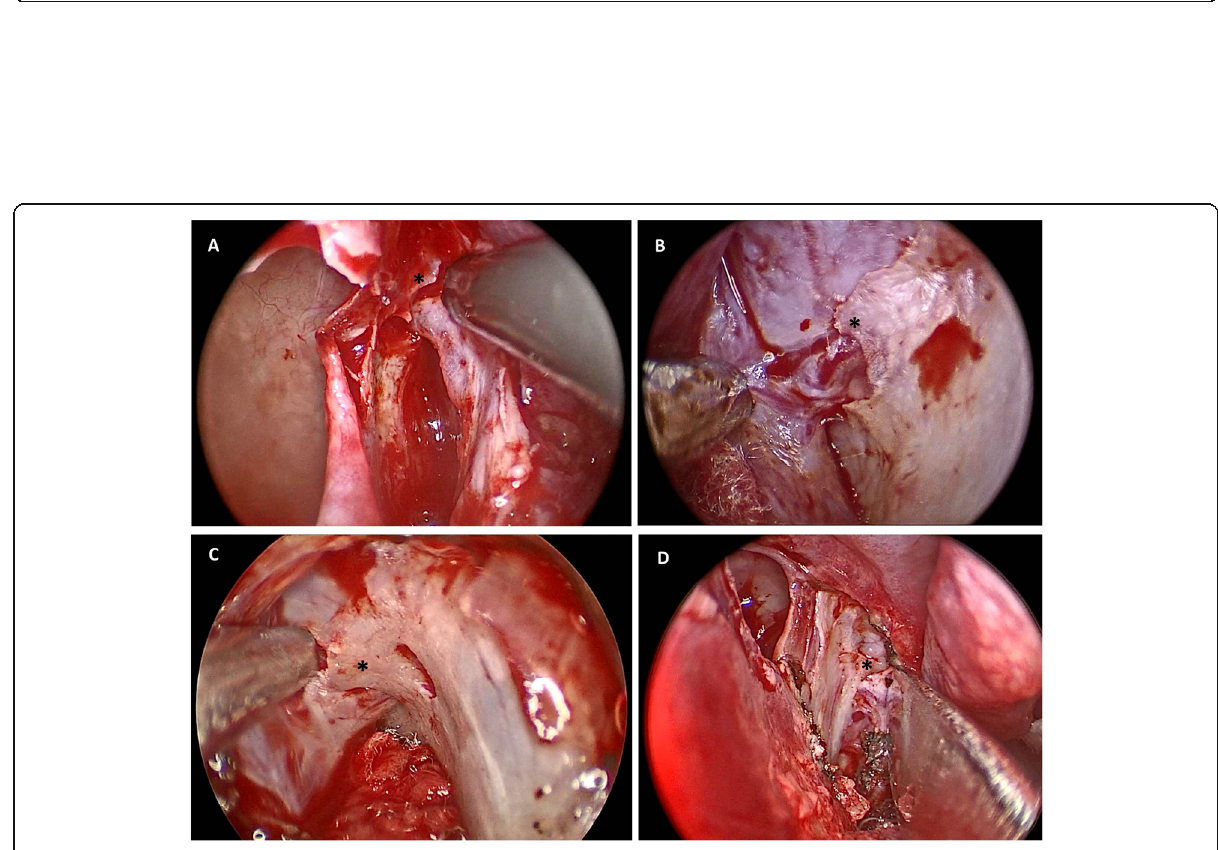
Fig. 4 a – d Endoscopic view of Crista ethmoidalis (black star); it was partially eroded in 2 cases from epistaxis group ( a , b ) and intact in 2 cases from the non-epistaxis group ( c , d )